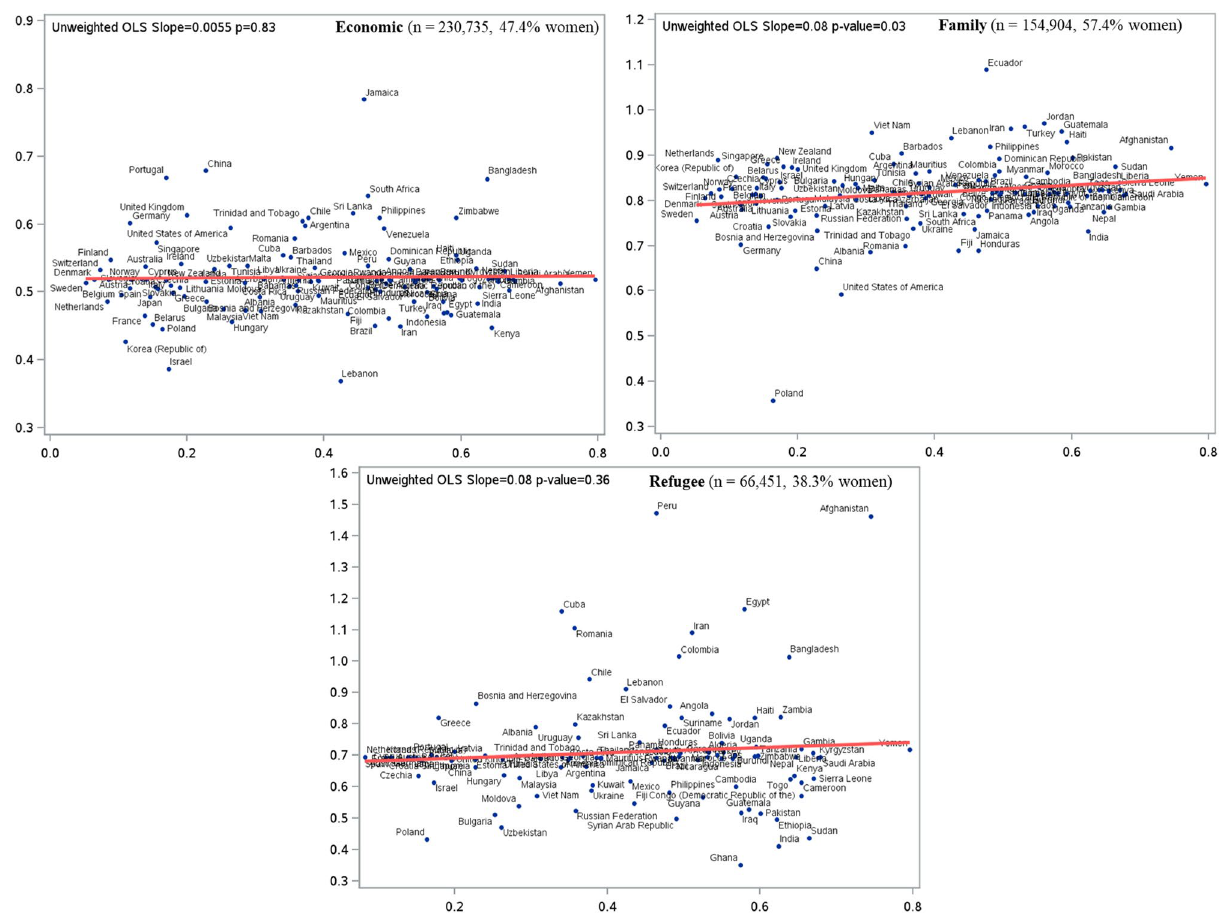
Figure 2. Results of hierarchical model-specific predicted country-specific hazard ratios (HR) of ischemic stroke in women compared men (Y-axis) and their association with country-level gender inequality index, GII, (X-axis) stratified by immigration